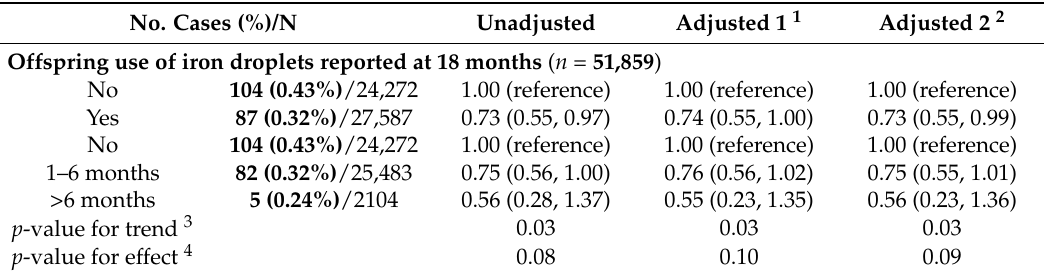
Table 3. Associations between offspring intake of iron droplets during first 18 months of life in relation to later risk of type 1 diabetes.